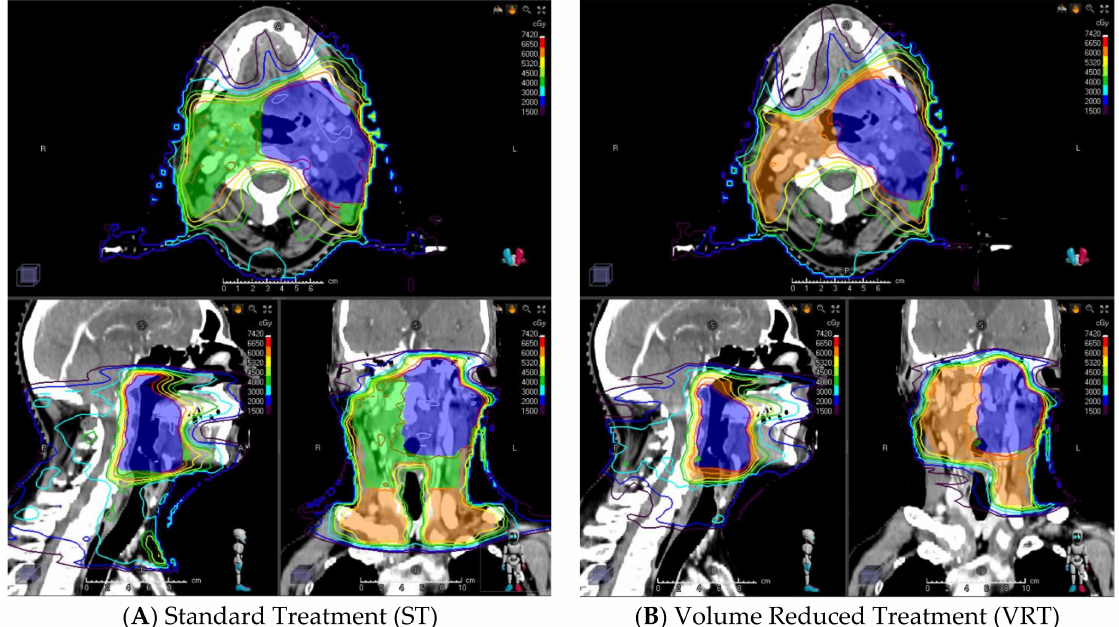
Figure 1. A Patient with an oropharyngeal carcinoma cT4 cN2b cM0 and lymph node involvement of level 2 on the left side. While PTV_70 (high dose volume; blue) shows identical extension, PTV_63 (intermediate dose volume; green) and PTV_56 (elective volume, orange) show a significant reduction in treated volume. The present example clearly depicts the involvement of levels 2–4 bilaterally in the standard treatment arm ( A ) while the plan from the simulated reduced volume arm ( B ) is seen to end caudally at level 2 on the right side and limited to levels 2 and 3 on the left side. The reduced-volume plan ( B ) achieves a considerable dose reduction to caudal anatomical structures potentially resulting in reduced short- and long-term